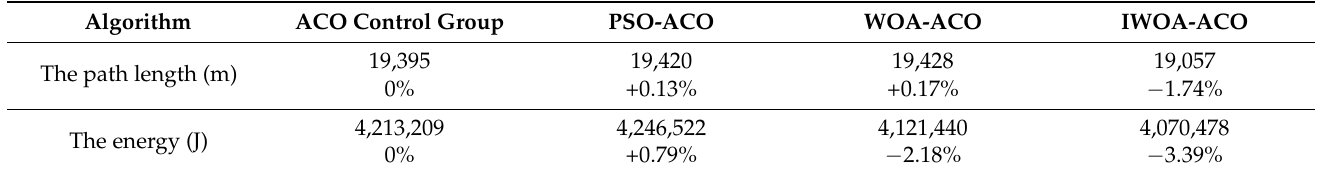
Table 6. The path length and energy consumption data in the simulation of bump